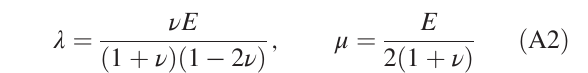
where ρ is the density of the material. The Lam´e constants